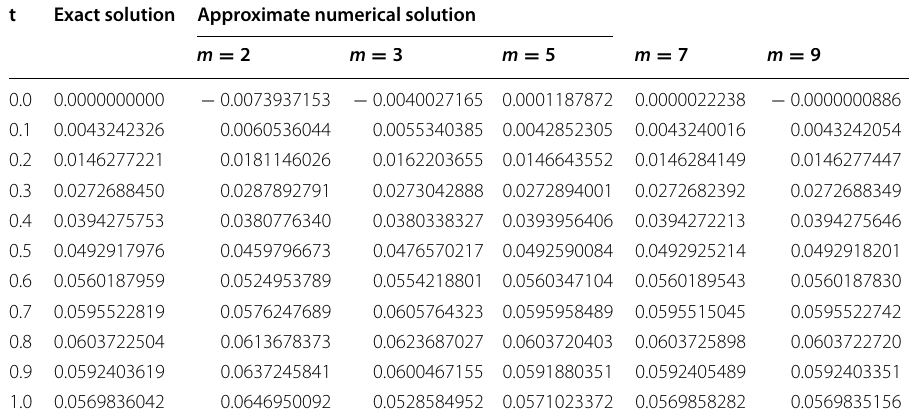
Table 3 Numerical results of solutions y ( t ) corresponding to Example 2 t Exact solution Approximate numerical solution